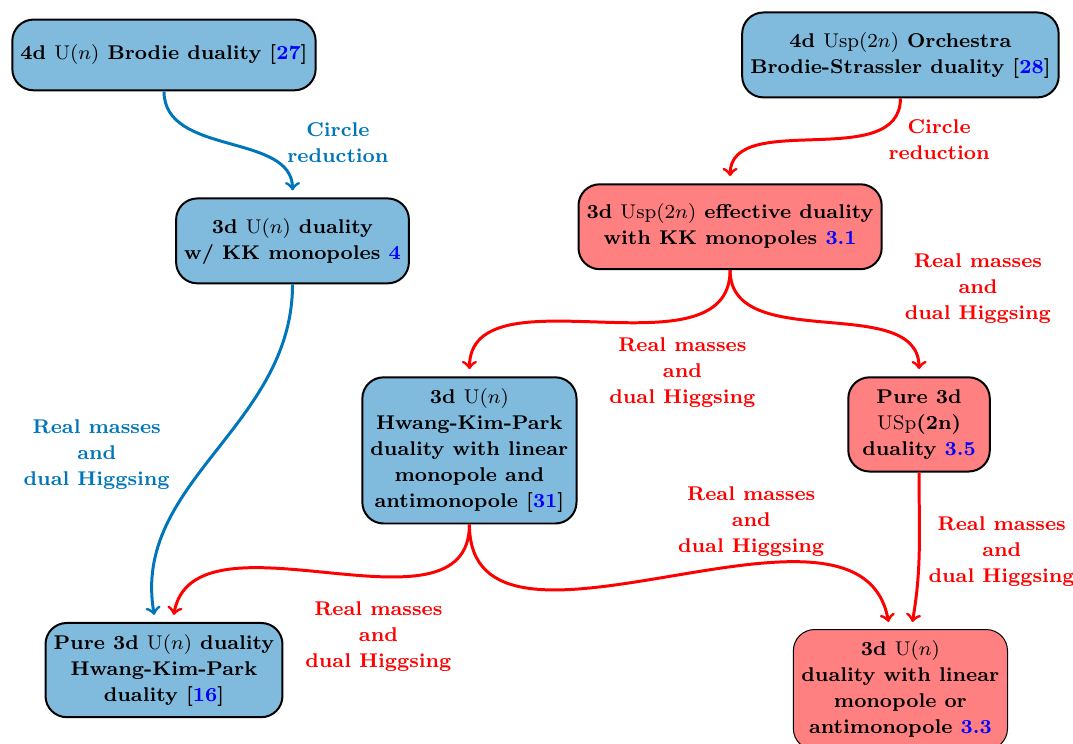
Figure 1 . Survey of the dualities and the flows studied in this paper. The blue boxes and arrows represents dualities and flows that have already been proposed and studied in the literature. The red boxes and arrows represent the dualities and the flows proposed and analyzed